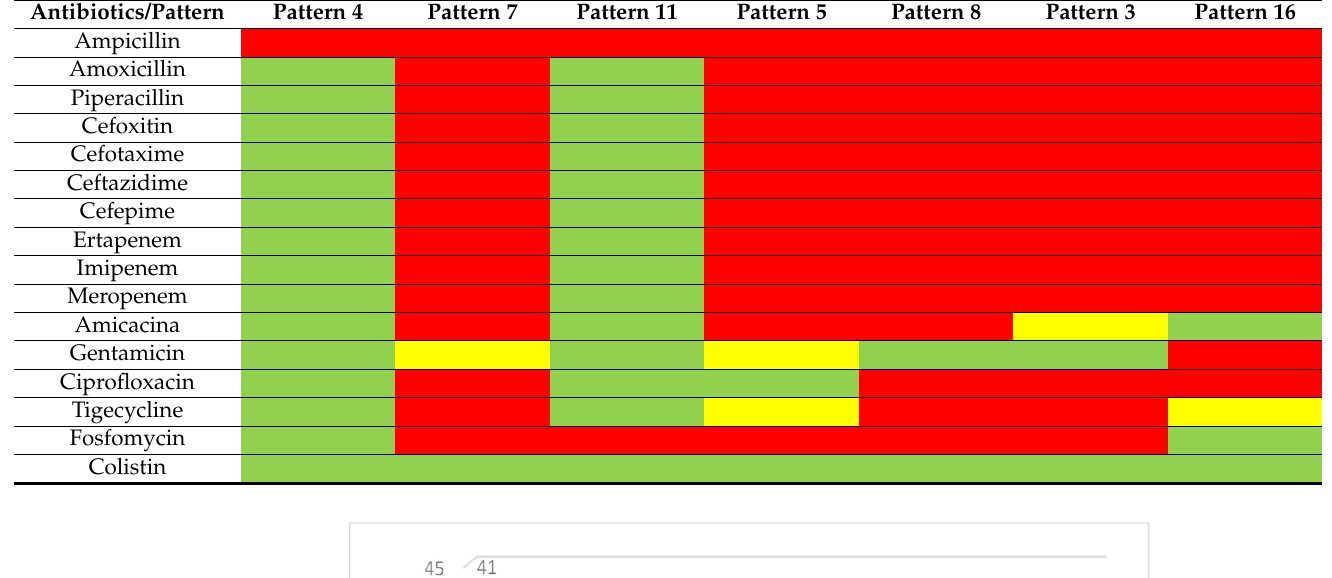
Table 3. Graphical representation of multidrug resistance. The antibiotics that are not effective are red, the ones with a good efficacy are green, and the intermediate are yellow (from the database described in Section 2.2).